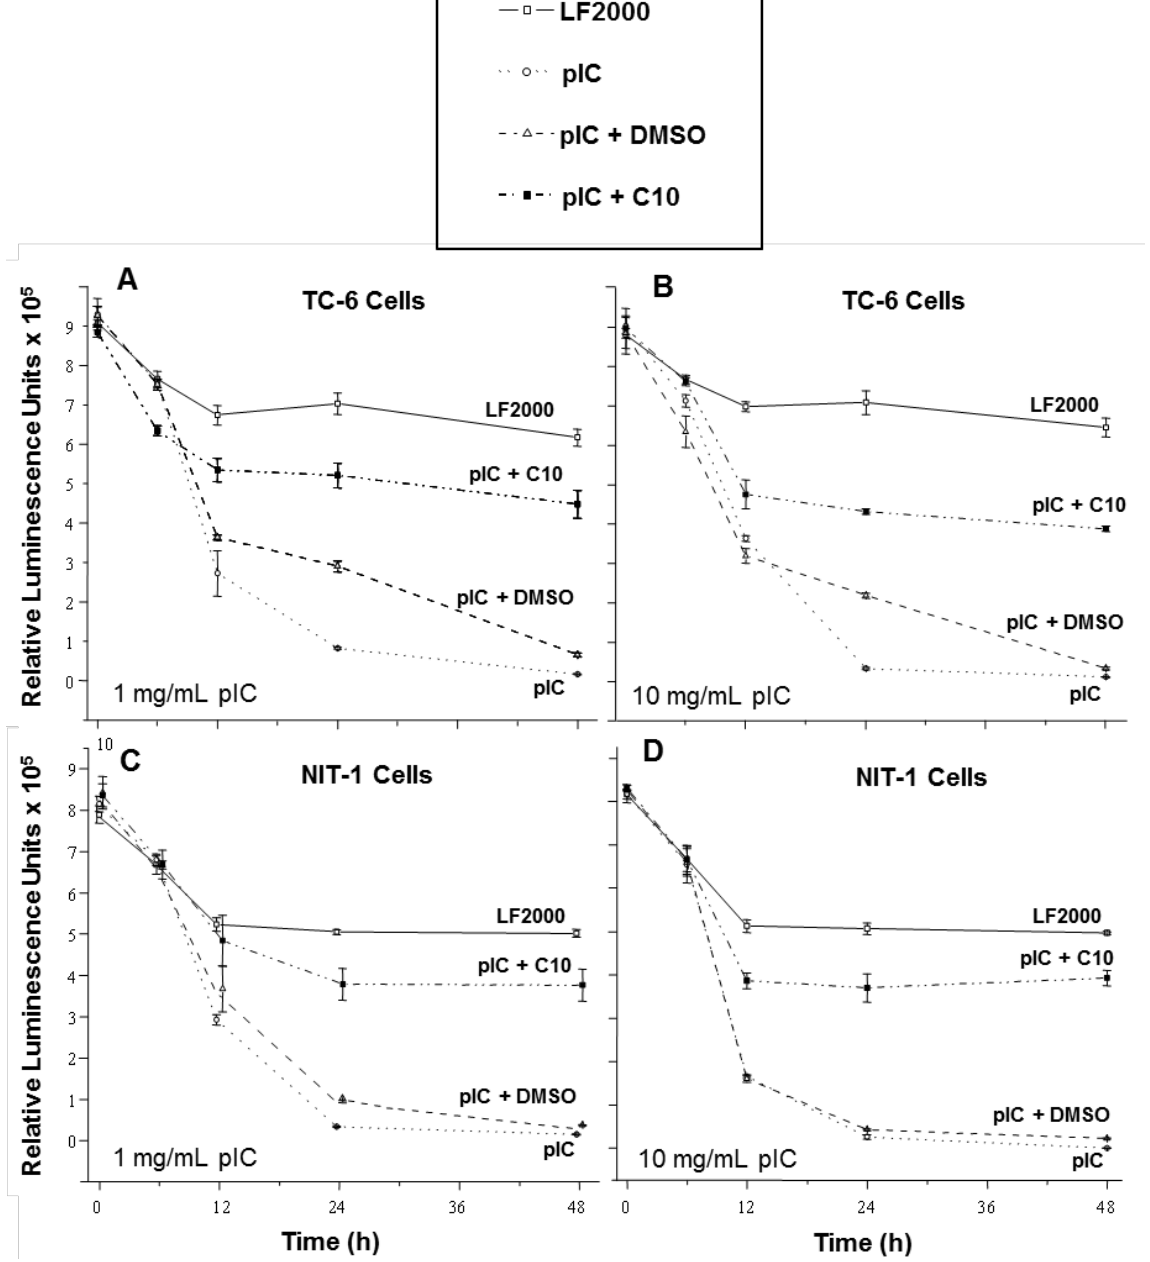
Figure 1. C10 prevents pIC-induced cytotoxicity in pancreatic beta cells in culture. TC-6 and NIT-1 cells were transfected with 1 mg/mL ( A & C ) and 10 mg/mL ( B & D ) of pIC. TC-6 and NIT-1 cells were either mock transfected (— □ —), transfected with pIC ( … ○ … ), or transfected with pIC and treated with either DMSO (solvent)(– – Δ – –) or 0.5 mM C10 (– · ■ – ·) for the indicated times. At 6, 12, 24, and 48 h post-transfection, the viability of cells was measured using the Cell Titer-Glo Luminescent Cell Viability